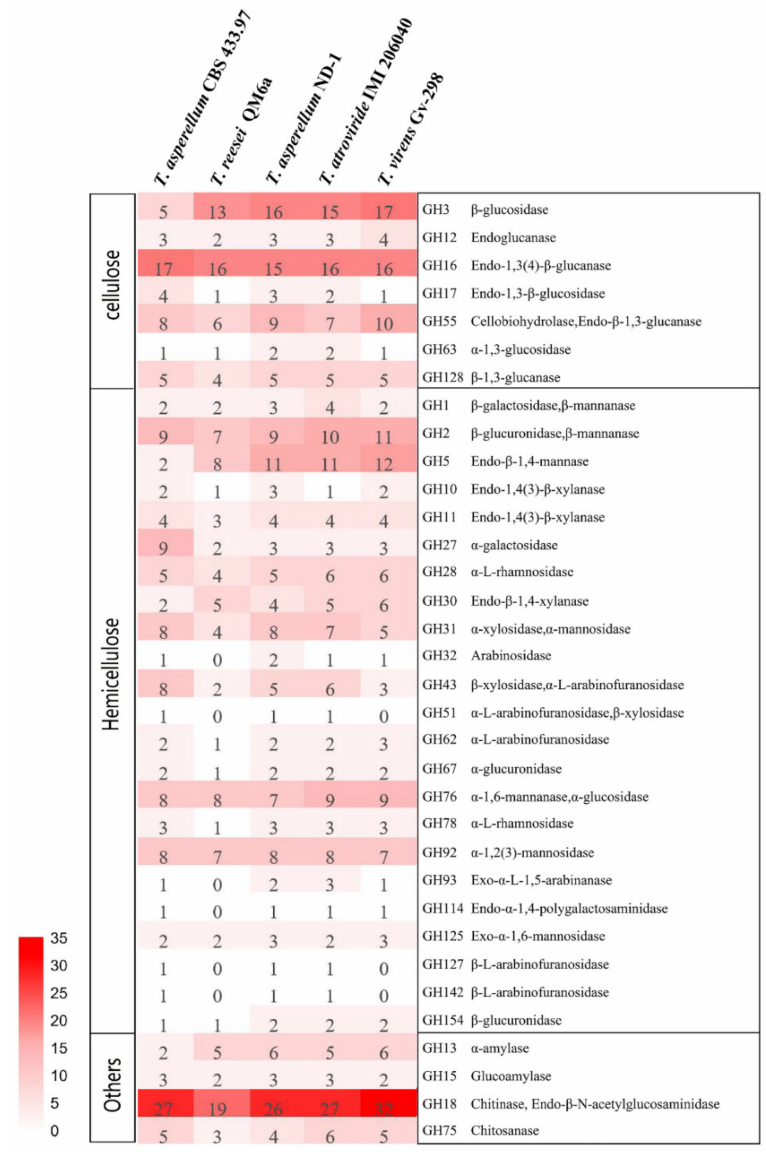
Figure 6. Heat map showing the distribution of glycoside hydrolases (GHs) in the genomes of T. atroviride IMI 206040, T. virens Gv-298, T. reesei QM6a, T. asperellum ND-1, and T. asperellum CBS 433.97. CAZymes families are grouped according to their activities in major components of plant cell